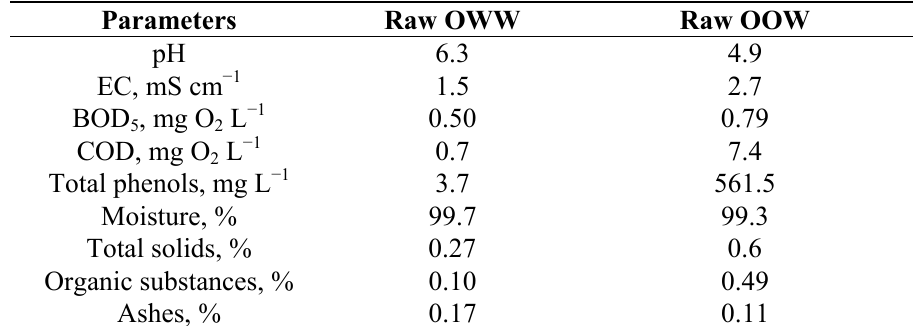
Table 1. Physicochemical characterization determined of raw OWW and